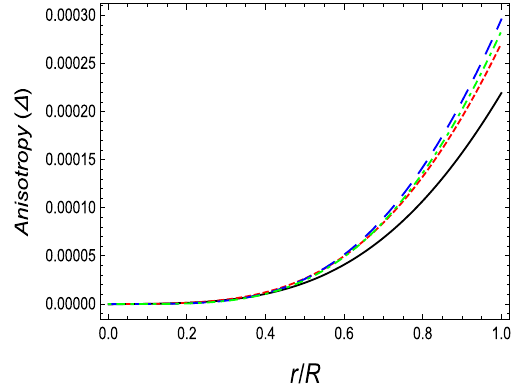
Fig. 1 Profiles of energy density ( ρ ), radial pressure ( p r ) and tan- gential pressure ( p t ) versus radial coordinate, r . The following set of numerical values have been used to plot these graphs: (i) Her X-1 (black curves) for α = − 2 . 3 , C = 0 . 5 ,η = 14 ,β = − 0 . 177 , k = 5 . 1 × 10 − 5 ,δ = 0 . 001473 ,γ = − 20 . 6604, (ii) 4U 1538-52 (red curves) for α = − 2 . 3 , C = 0 . 5 ,η = 15 ,β = − 0 . 177 , k =